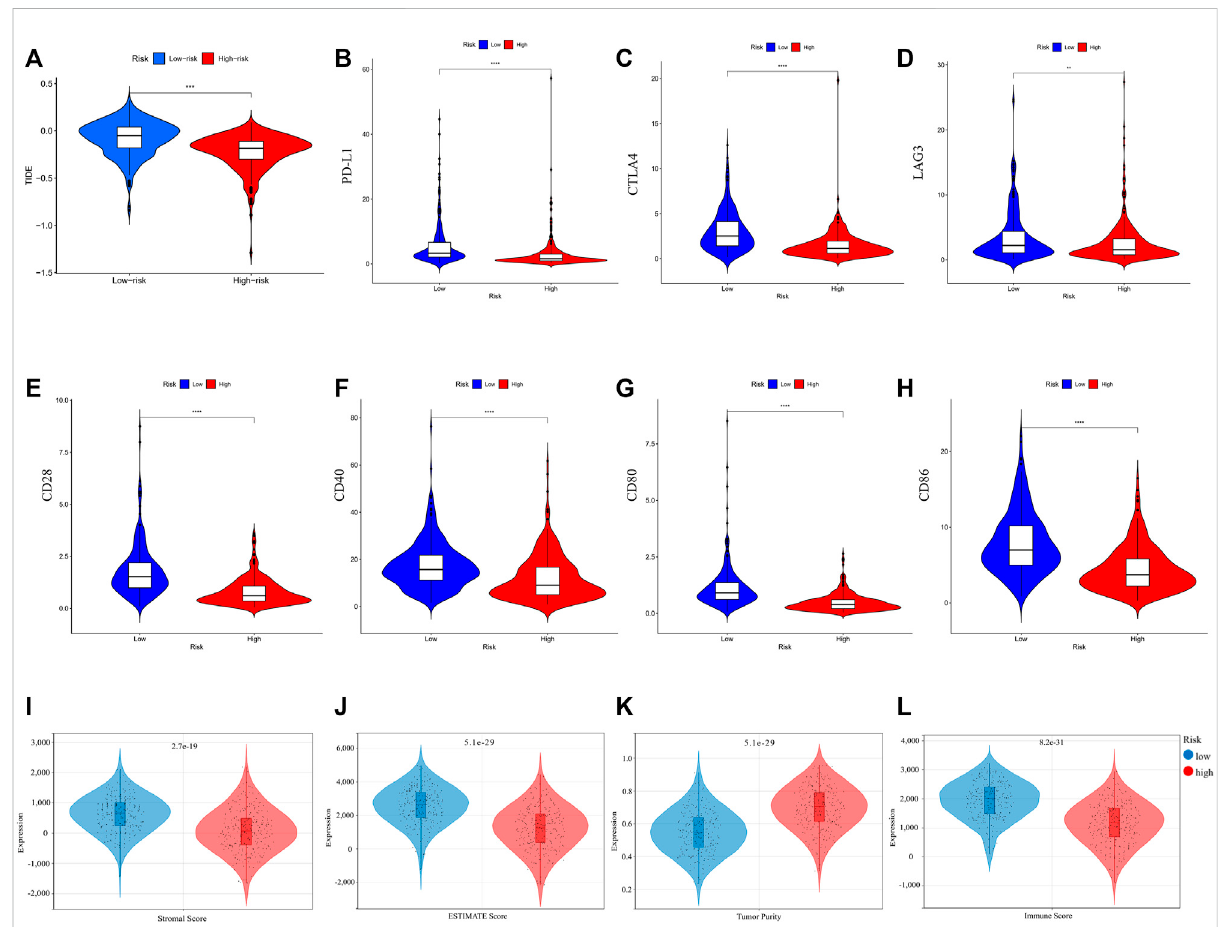
FIGURE 8 (A) TIDE score of different risk groups. (B – H) Comparison of immune checkpoint expression between different risk groups. (I – L) Tumor immune microenvironment of LUAD comparisons between high-risk and low-risk groups. (I) stromal score; (J) ESTIMATE score; (K) tumor purity; and (L) immune score. (wilcox.test, p values were as follows: * p < 0.05; ** p < 0.01; *** p <